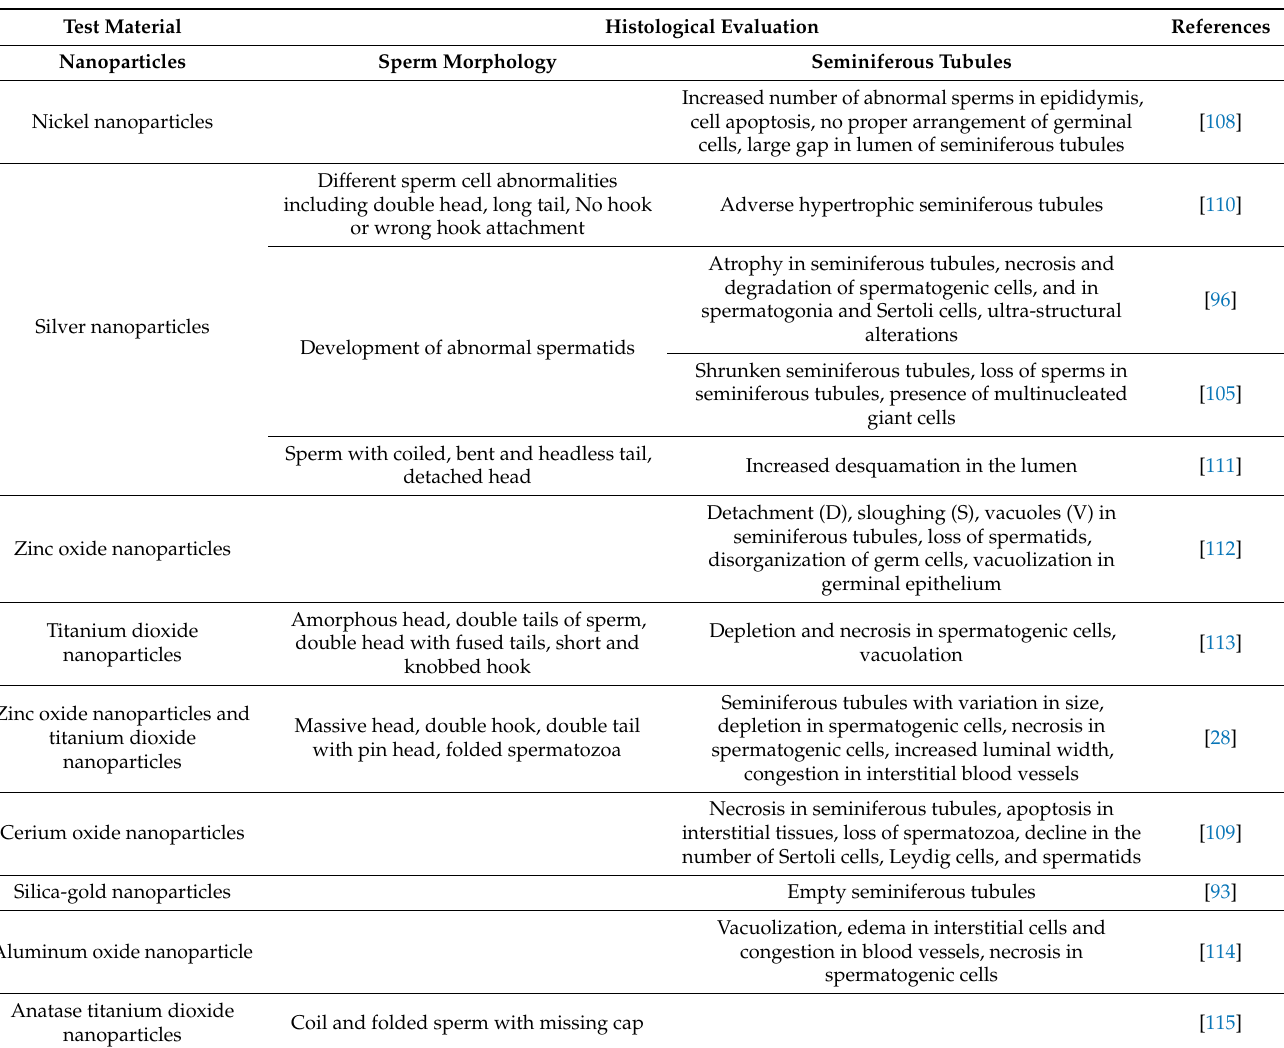
Table 2. NPs induce histological abnormalities in sperm and seminiferous tubules, disturbing sperm